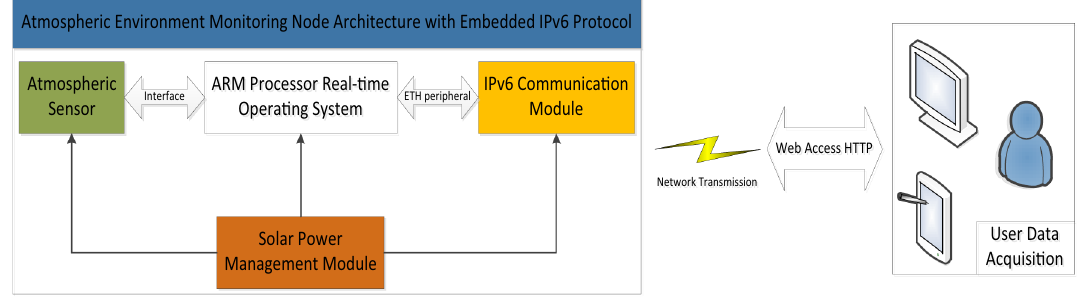
Figure 1. Structure of the